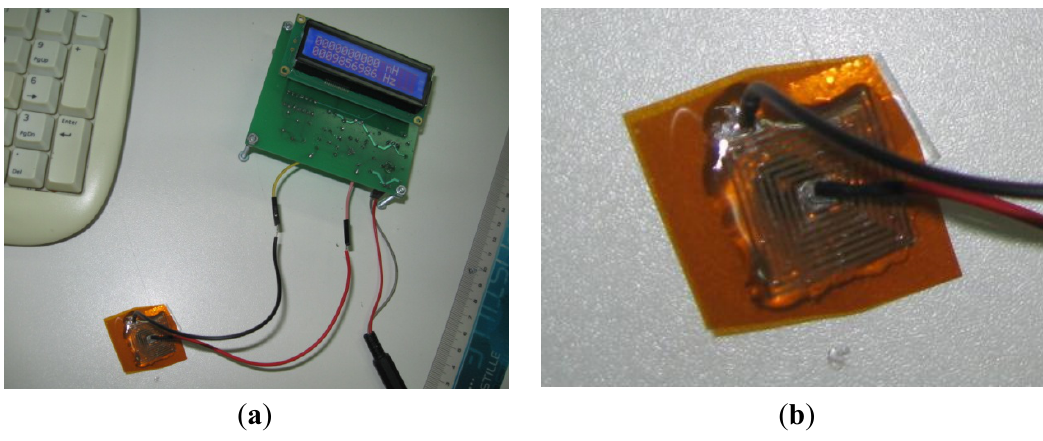
Figure 14. ( a ) Sensor detecting a metallic ball ( b ) Zoom: Printed inductor on top of the